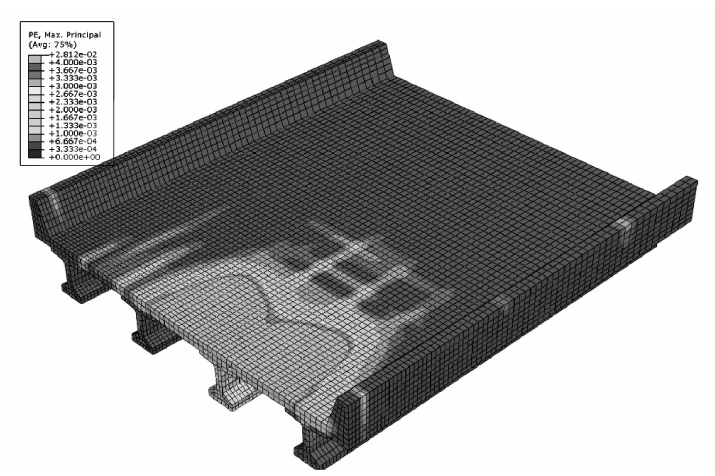
Fig. 23. Maximum principal plastic strain, blast above, centered on a girder. Top